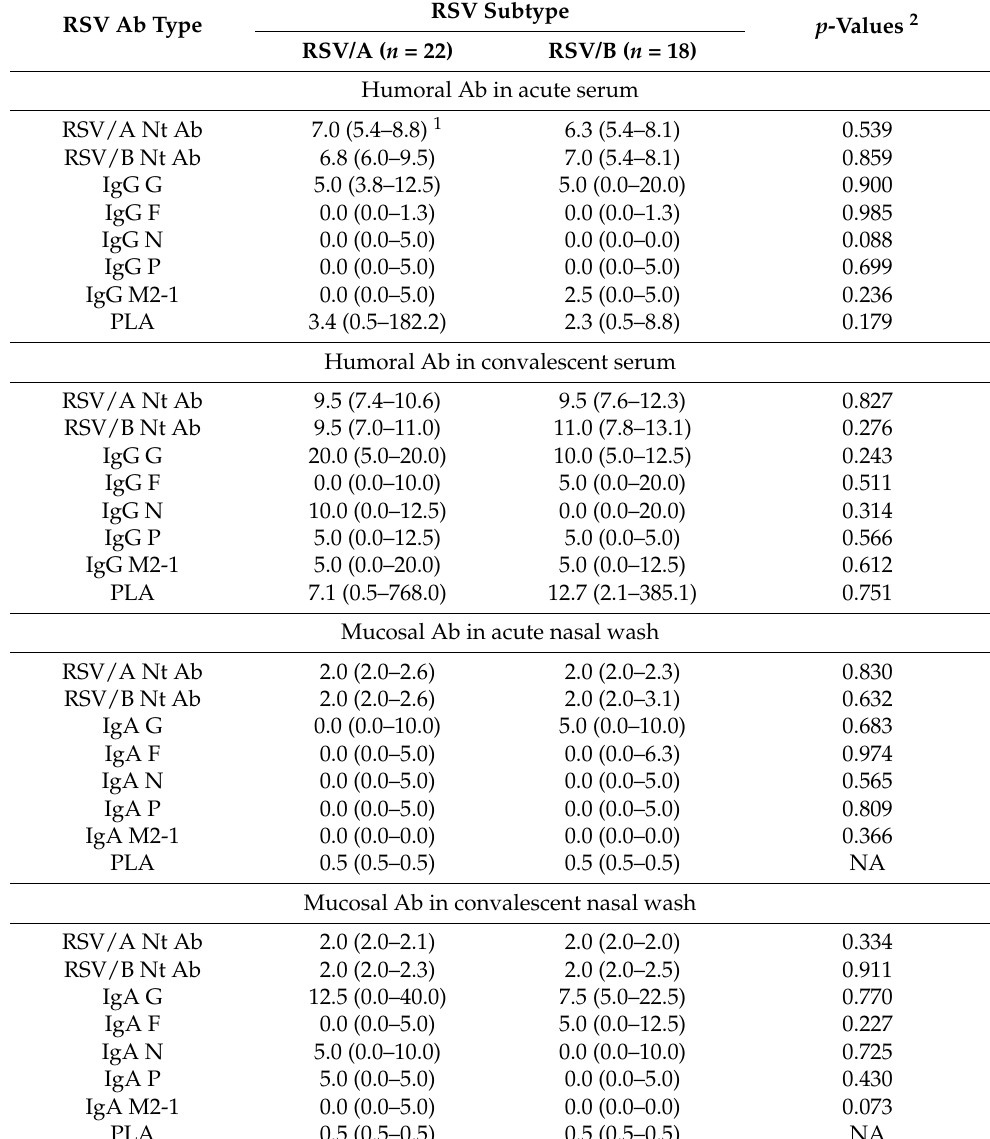
Table 4. Comparison of Humoral and Mucosal RSV Antibody Level between RSV/A- and RSV/B- Infected